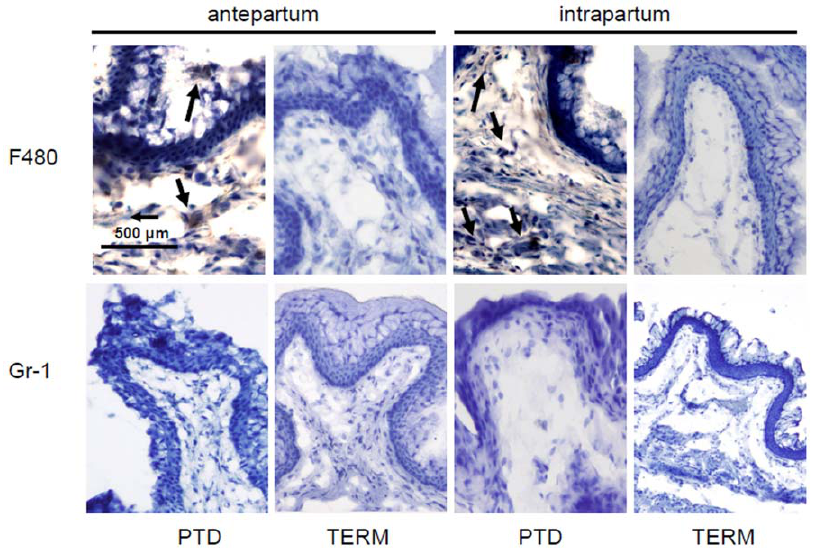
Figure 3. Inflammatory cells in cervical tissue from mice that deliver preterm and at term. A- F4/80 staining in cervical tissue. Increased macrophage infiltration (black arrows) was observed in the cervix of mice that deliver preterm antepartum and intrapartum. In contrast no macrophages were observed in the cervix of mice that deliver at term antepartum and intrapartum. Original magnification is 6 20. B- Gr-1 staining in cervical tissue. No neutrophil infiltration was observed at preterm or term cervical samples. Original magnification is 6 20. 4 slides per animal were stained and 6–8 animals were studied in each group.